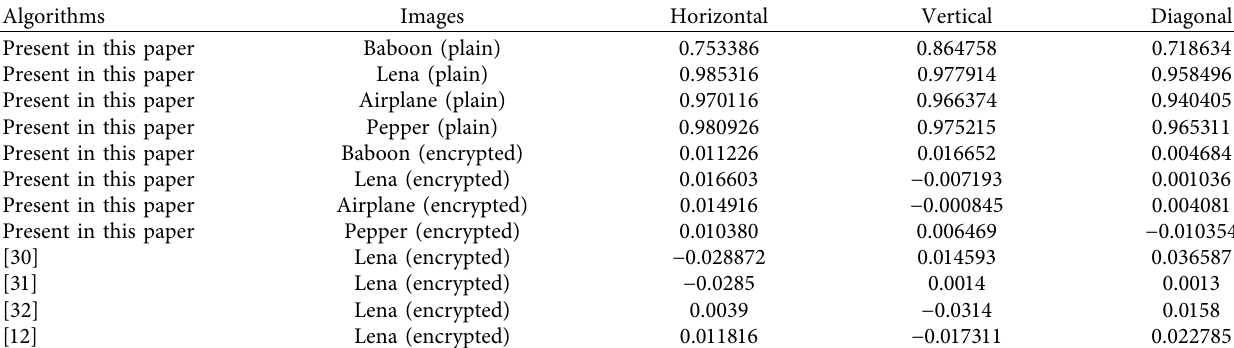
Table 2: Correlation coefficients of selected adjacent